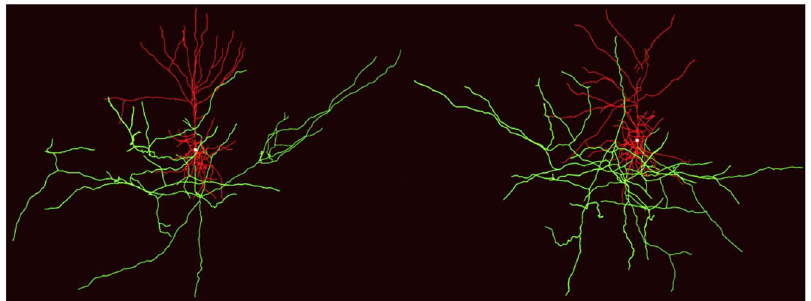
Figure 3. Examples of NETMORPH-generated L2/3 pyramidal neurons. Axons are shown in green, and dendrites are depicted in red. The neurons were grown with outgrowth parameters (Table 1) optimized on the dataset of L2/3 pyramidal cells from